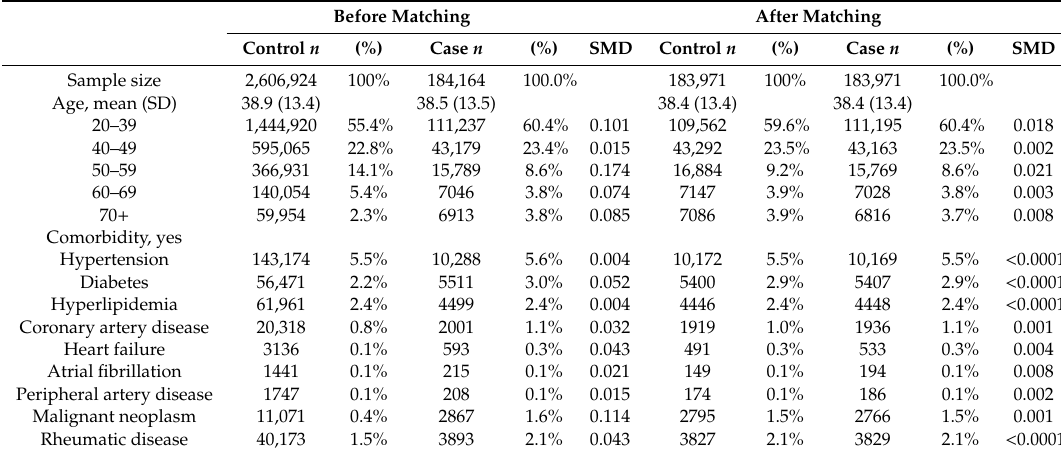
Table 1. Baseline characteristics of anemia cases and non-anemia controls before and after propensity score matching (PSM). Before Matching After